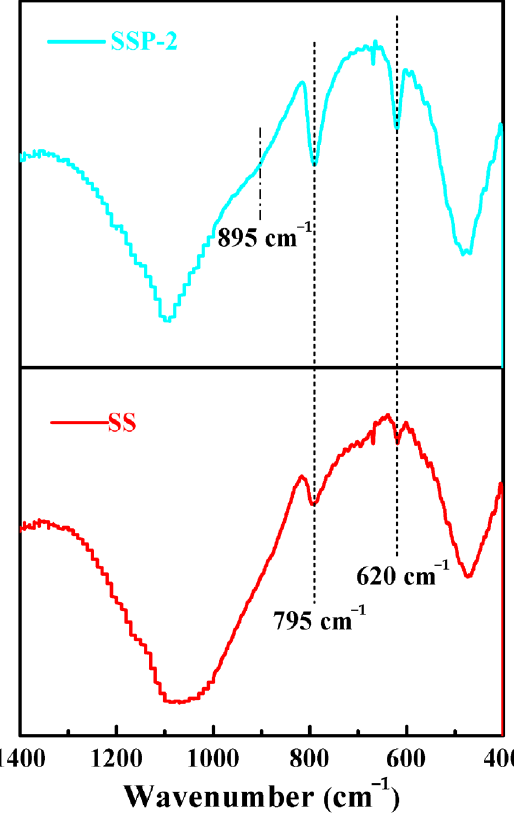
Figure 6. FTIR patterns of samples SS and SSP ‐ 2 fired at 850 °C for 30 min.